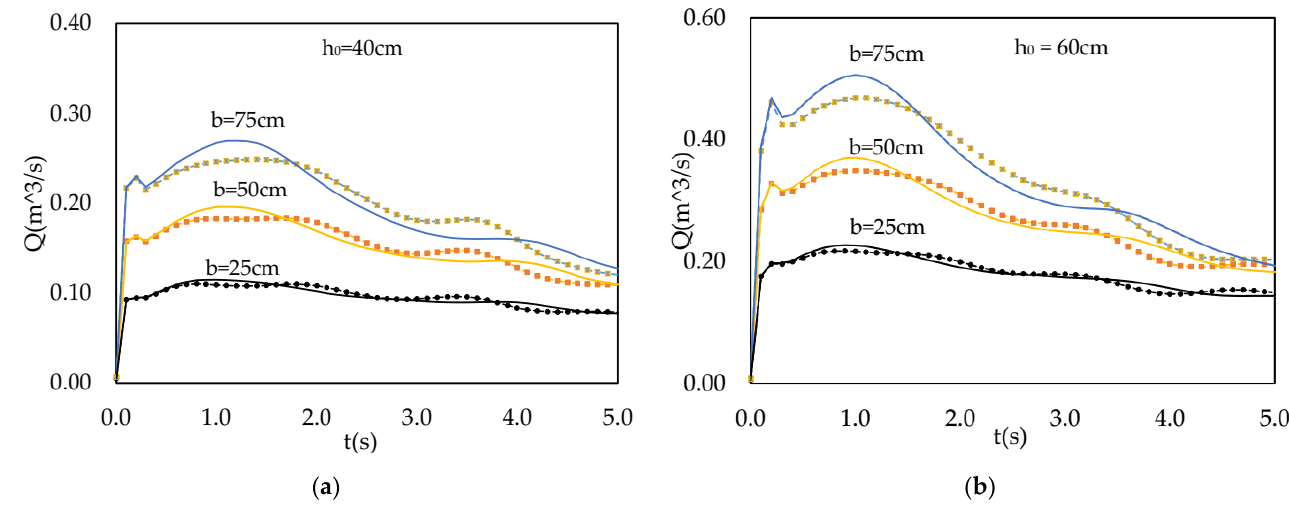
Figure 16. Discharge hydrographs taken with output interval 0.1 s. Solid line–cases B. Marker line–cases A. ( a ) h 0 = 40 cm, ( b ) h 0 = 60